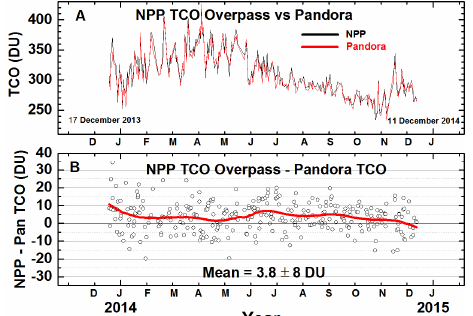
Figure 6. (a) NPP overpass TCO data for Boulder, Colorado, com- pared to Pandora TCO data averaged over a 16min interval centered on the OMI overpass time. (b) OMI TCO – Pandora TCO and a Lowess(0.2) fit (red